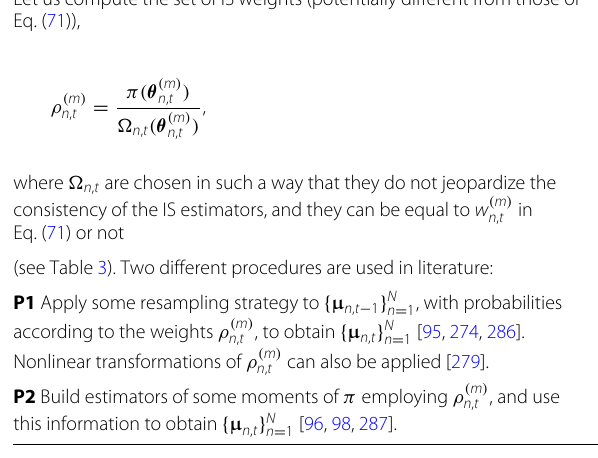
Table 4 Adaptation based on weighted samples